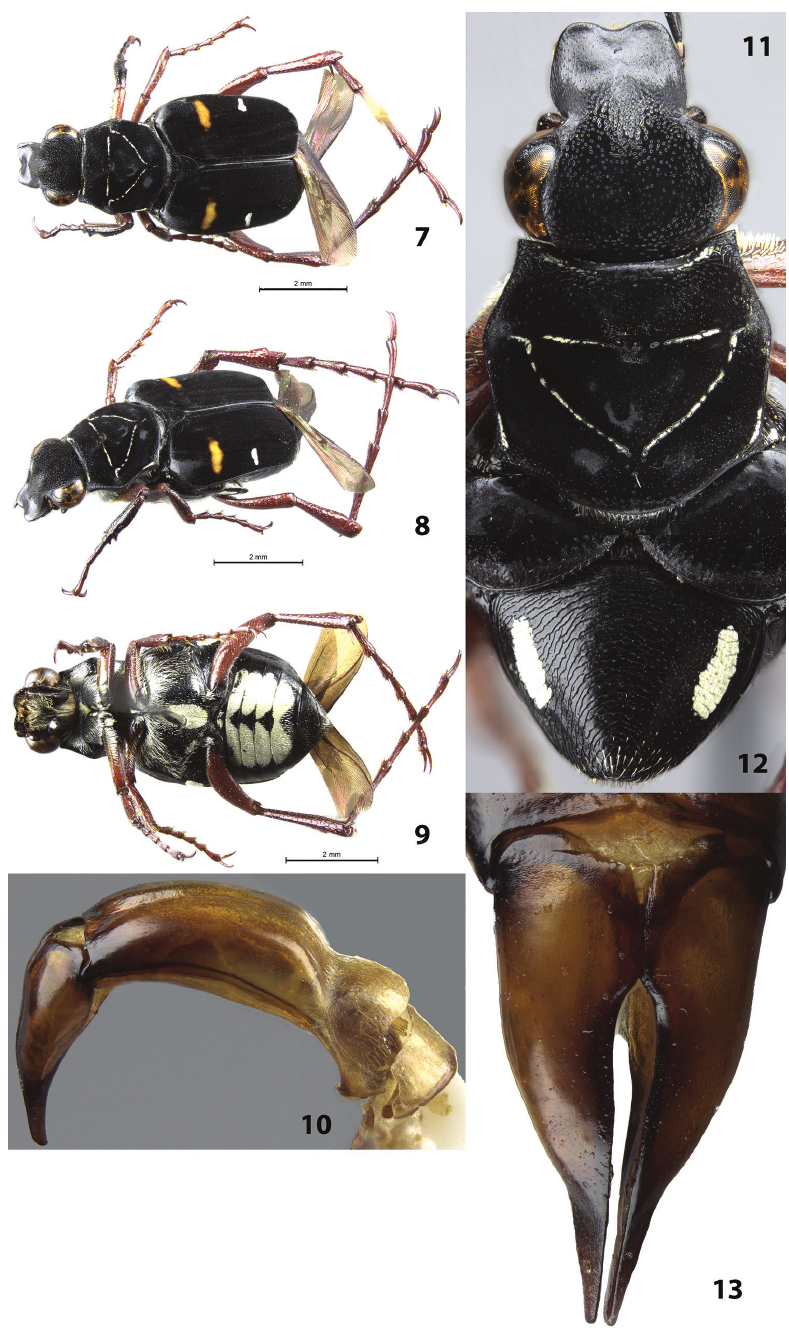
Figures 7–13. Trigonopeltastes formidulosus sp. n., male holotype. 7 Dorsal view of habitus 8 Oblique view of habitus 9 Ventral view of habitus 10 Lateral view of genitalia 11 Head and pronotum 12 Pygidium (male paratype used for this photograph) 13